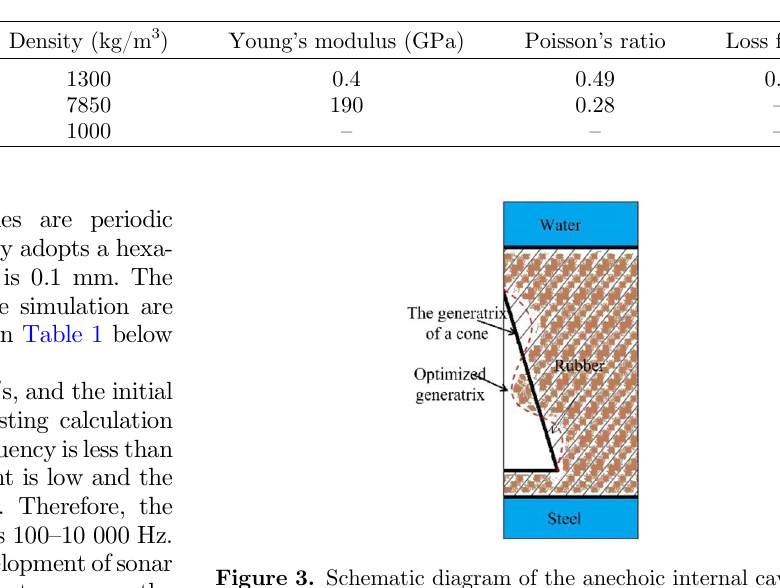
Table 1. Model material parameter table.